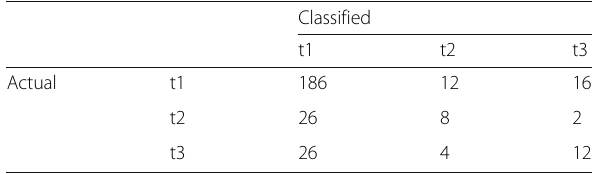
Table 5 Confusion matrix for the visual image classifier (3 types)